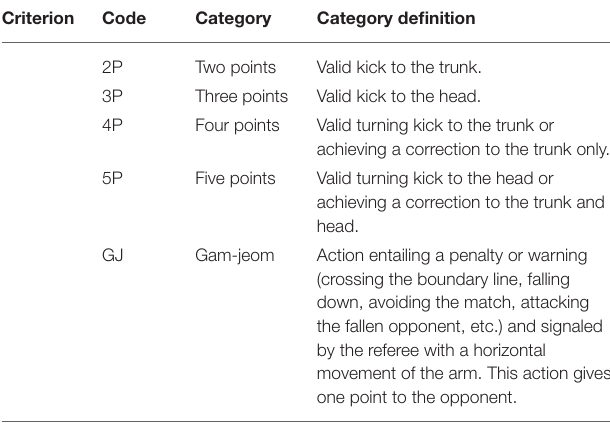
TABLE 1 | Observation tool and coding system.